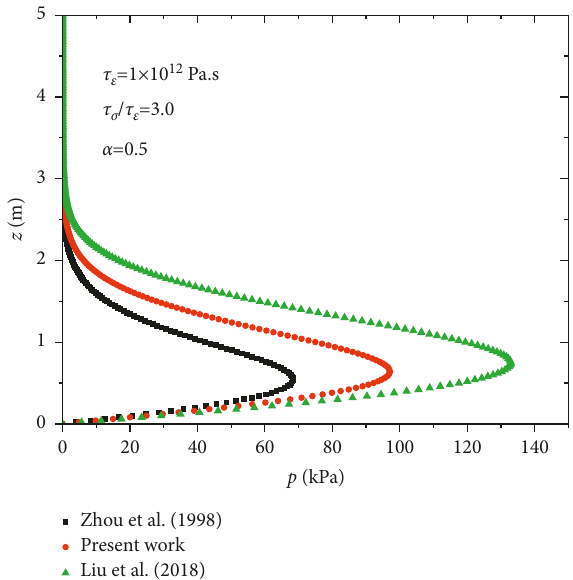
Figure 2: Comparison of excess pore pressure among solutions of Zhou et al. [25], Liu et al. [14], and present work.